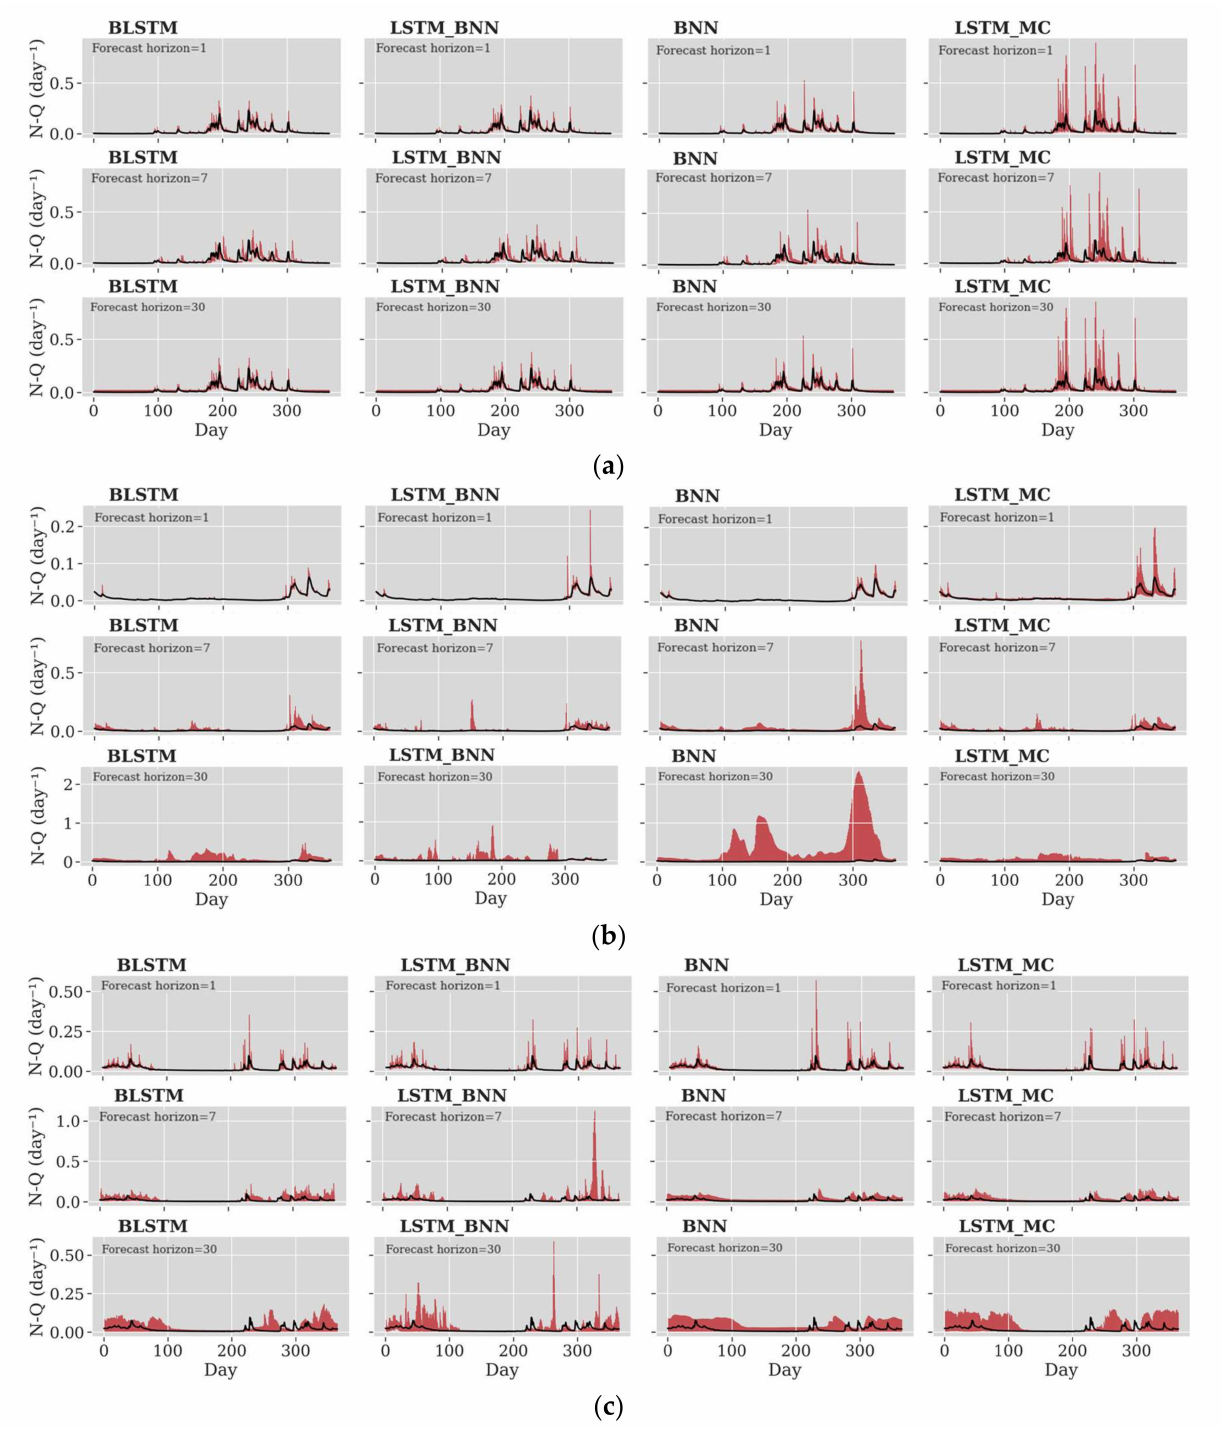
Figure 12. Prediction results of all models with 1, 7, and 30 days ahead forecasting for ( a ) case study I, ( b ) case study II, and ( c ) case study